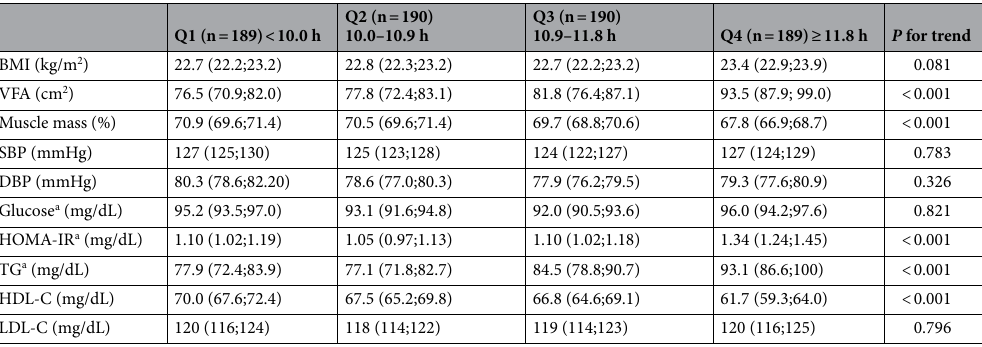
Table 2. Associations of sedentary time with cardiometabolic risk components. Values shown are adjusted means (95% confidence intervals). Linear regression models were used, with adjustments for age, sex, smoking status, alcohol intake, energy intake, and moderate-vigorous physical activity. BMI body mass index, VFA visceral fat area, SBP systolic blood pressure, DBP diastolic blood pressure, HOMA-IR homeostasis model assessment of insulin resistance, TG triglyceride, HDL-C high-density lipoprotein cholesterol, LDL-C low- density lipoprotein cholesterol. a Log-transformed values were used, and the adjusted means were back- transformed.